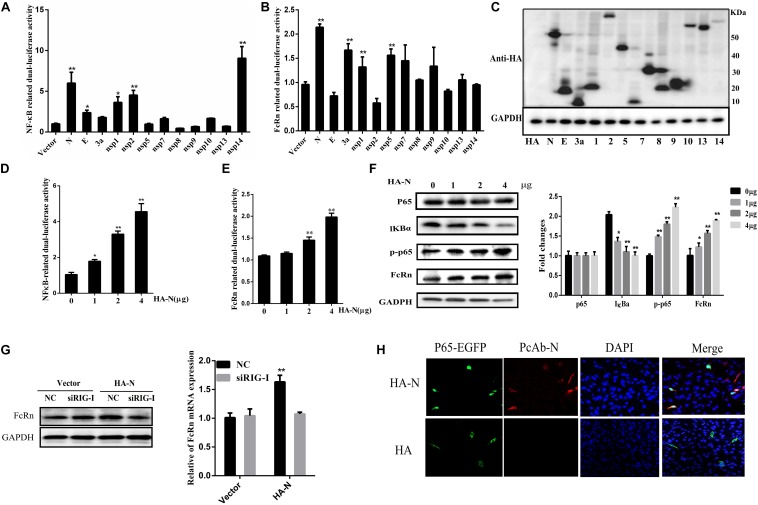
Transmissible gastroenteritis virus N induces FcRn and NF-κB activation. (A,B) IPEC-J2 cells were co-transfected with pRL-TK and FcRn-Luc or NF-κB-Luc together with each expression plasmid of TGEV proteins. (C) Lysates of transfected cells were subjected to Western blot with anti-HA antibody to detect viral protein expression. (D,E) IPEC-J2 were co-transfected with pRL-TK, FcRn-Luc or NF-κB-Luc, and TGEV N expression plasmids (1, 2 or 4 μg) for 36 h. The cell lysates were analyzed by dual-luciferase assay. (F) FcRn, IκBα, p65 and phosphorylated p65 (p-p65), and GAPDH was assayed by Western blot analysis. (G) IPEC-J2 cells were transfected with siRIG or NC siRNA for 24 h and subsequently retransfected with TGEV N-expression plasmids (4 μg) for an additional 24 h. FcRn expression were detected by Western blot analysis. The right panel represents the quantification of the bands by densitometry, corrected by the amount of GAPDH. (H) IPEC-J2 cells were co-transfected with the p65-EGFP fusion protein vector and an empty vector (HA) or the TGEV N expression vector (HA-N) for 24 h. NF-κB p65 (green), TGEV N (red), and the nuclei (blue) were visualized by confocal microscopy. ∗p < 0.05, ∗∗p < 0.01.